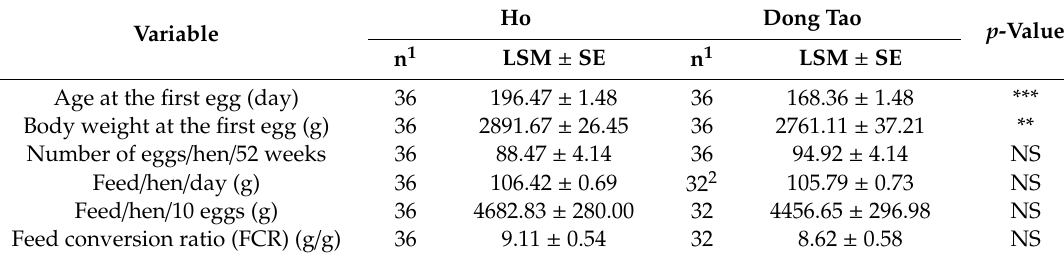
Table 6. Laying performances of Ho and Dong Tao